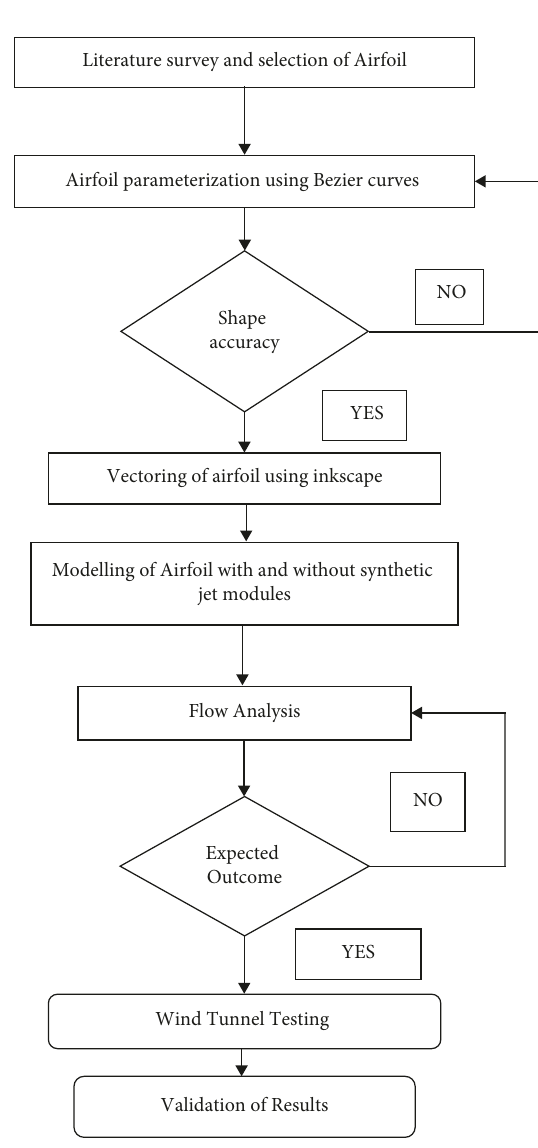
Figure 1: Flowchart for aerodynamic efficiency of airfoil im- provement using flow control